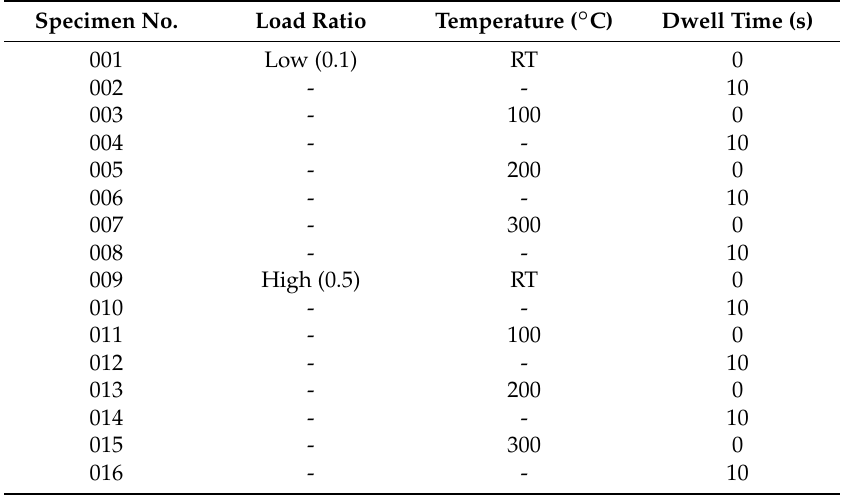
Figure 4. Schematic drawing of the loading waveforms: ( a ) triangular for the pure fatigue loading; ( b ) trapezoidal for the dwell fatigue loading. Table 3. Scheme of Fatigue Crack Growth (FCG) tests of CP-Ti under different load ratios and